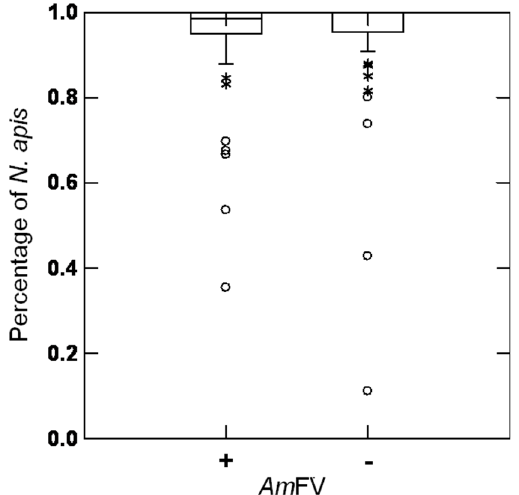
Figure 1. Proportion of Nosema apis positive colonies in Apis mellifera Filamentous virus (AmFV) positive and negative samples. Data were recorded from Swedish colonies ( n = 86). No significant differences were